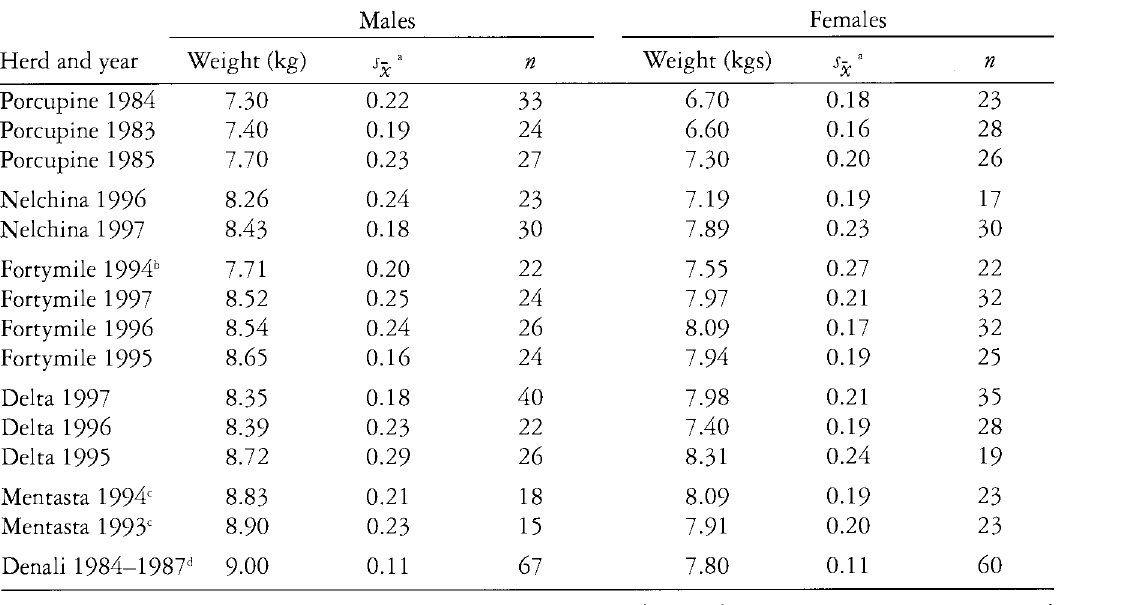
Table 7. Average newborn caribou weighrs from 6 Alaskan herds. Males